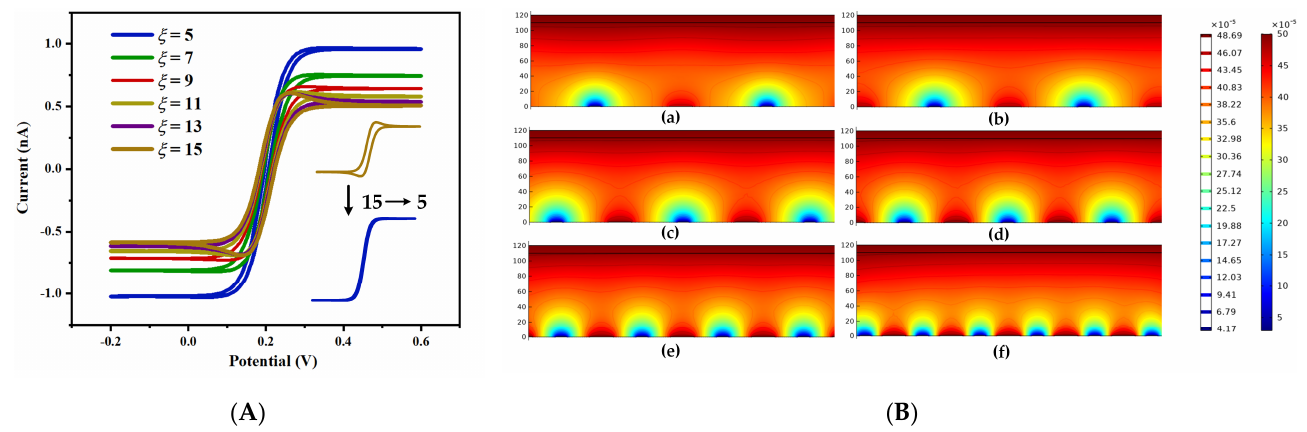
Figure 5. Simulation results diagrams of UIAE with different spacing-to-width ratios: ( A ) cyclic voltammogram; ( B ) concentration distribution diagram: ( a ), 15; ( b ), 13; ( c ), 11; ( d ), 9; ( e ), 7; ( f ), 5.